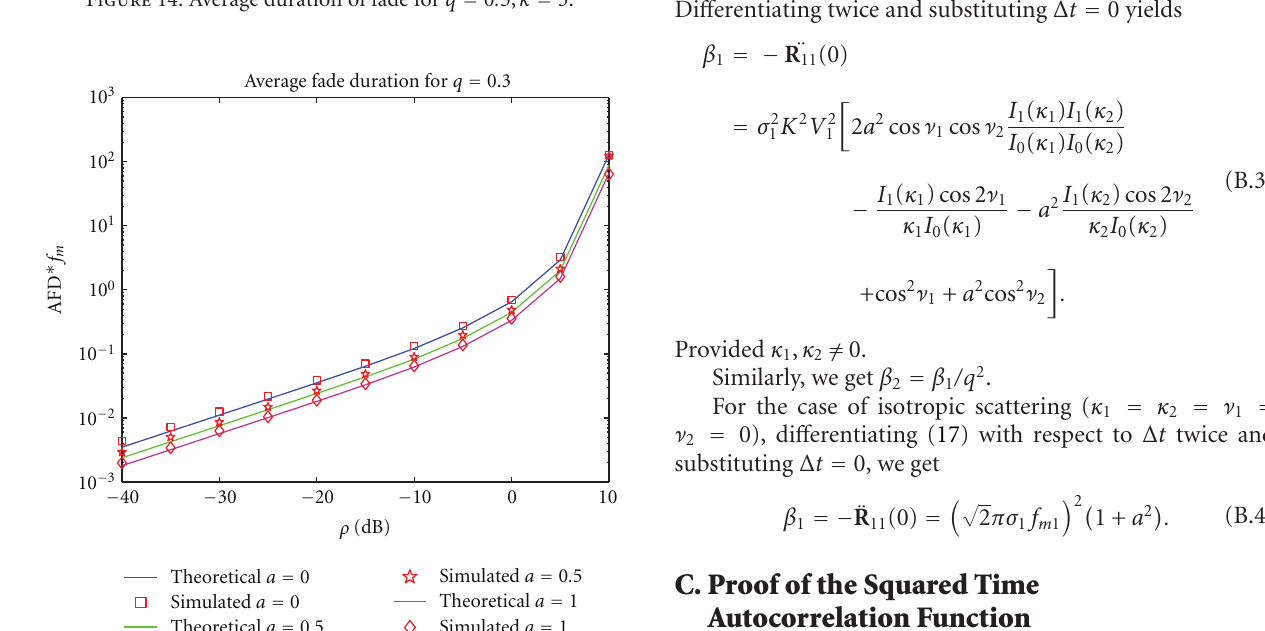
Figure 14: Average duration of fade for q = 0 . 5, k = 3.